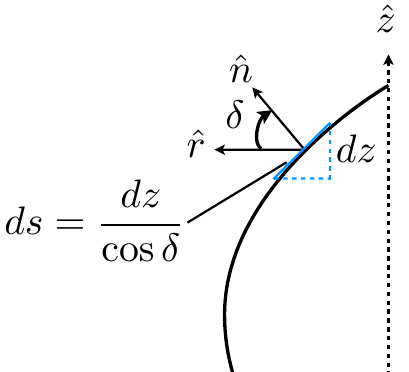
Figure 11. Cross-sectional length of blade segment for small changes in height. Blade curvature increases the area of the blade element for unit height, but sweep has no effect on the blade ele- ment area as it is a shearing